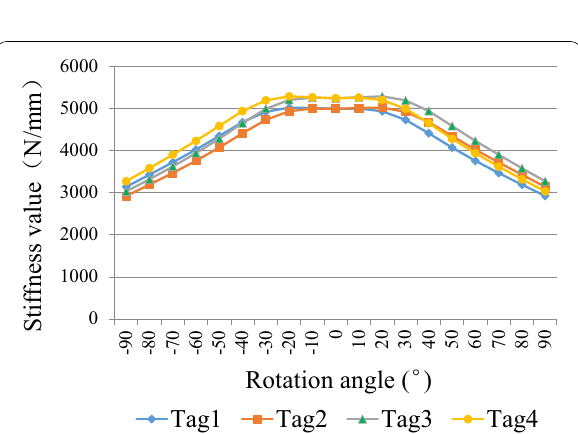
Figure 23 Comparison of k x in different positions